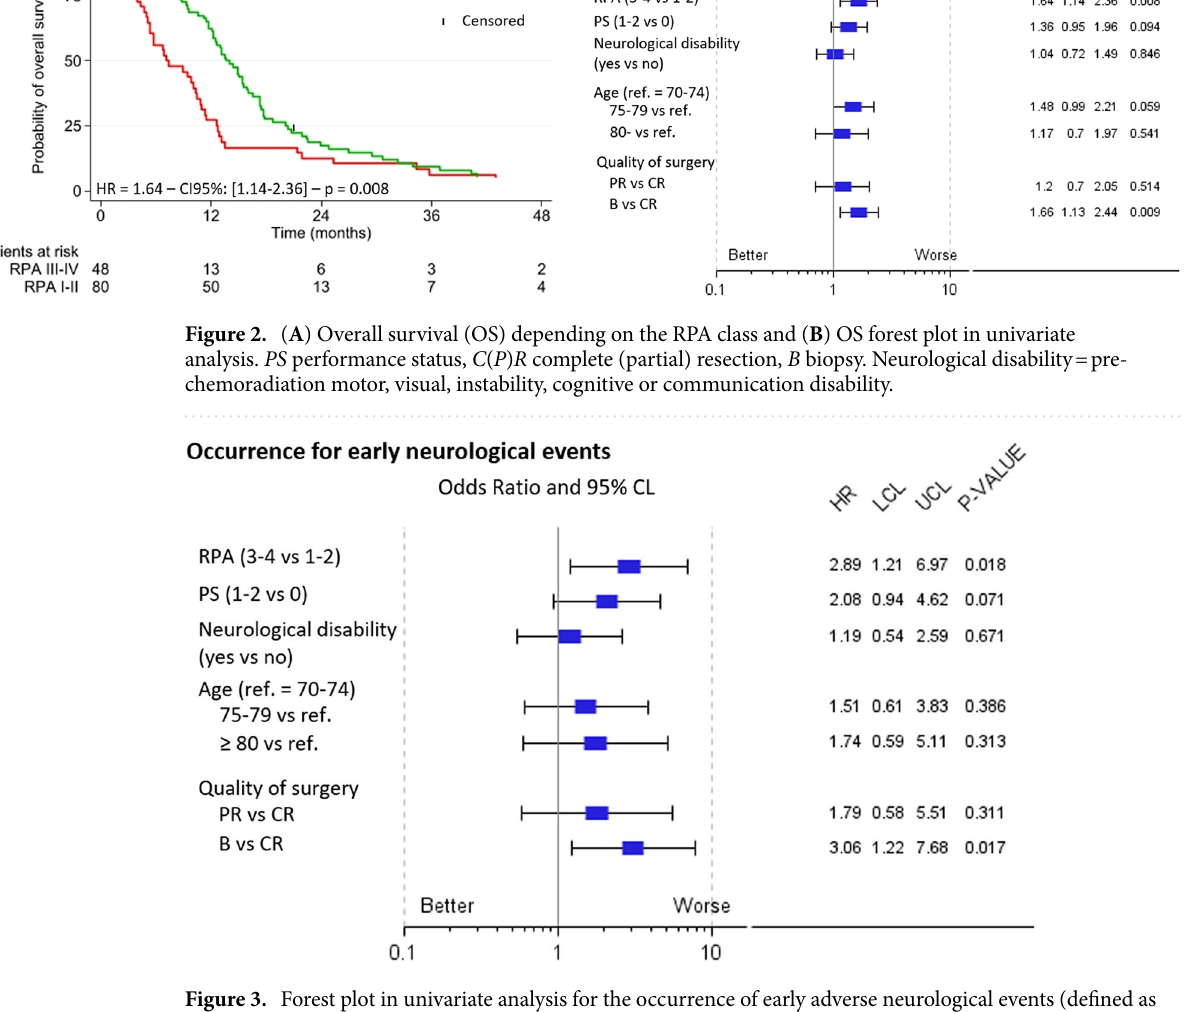
Figure 3. Forest plot in univariate analysis for the occurrence of early adverse neurological events (defined as the occurrence of intracranial hypertension symptoms and/or use of corticosteroids and/or hospitalization) for the subgroup of patients without neurological progression or death before the start of temozolomide maintenance (N = 103). CRT chemoradiation, PS performance status, C ( P ) R complete (partial) resection, B biopsy. Neurological disability = pre-CRT motor, visual, instability, cognitive or communication